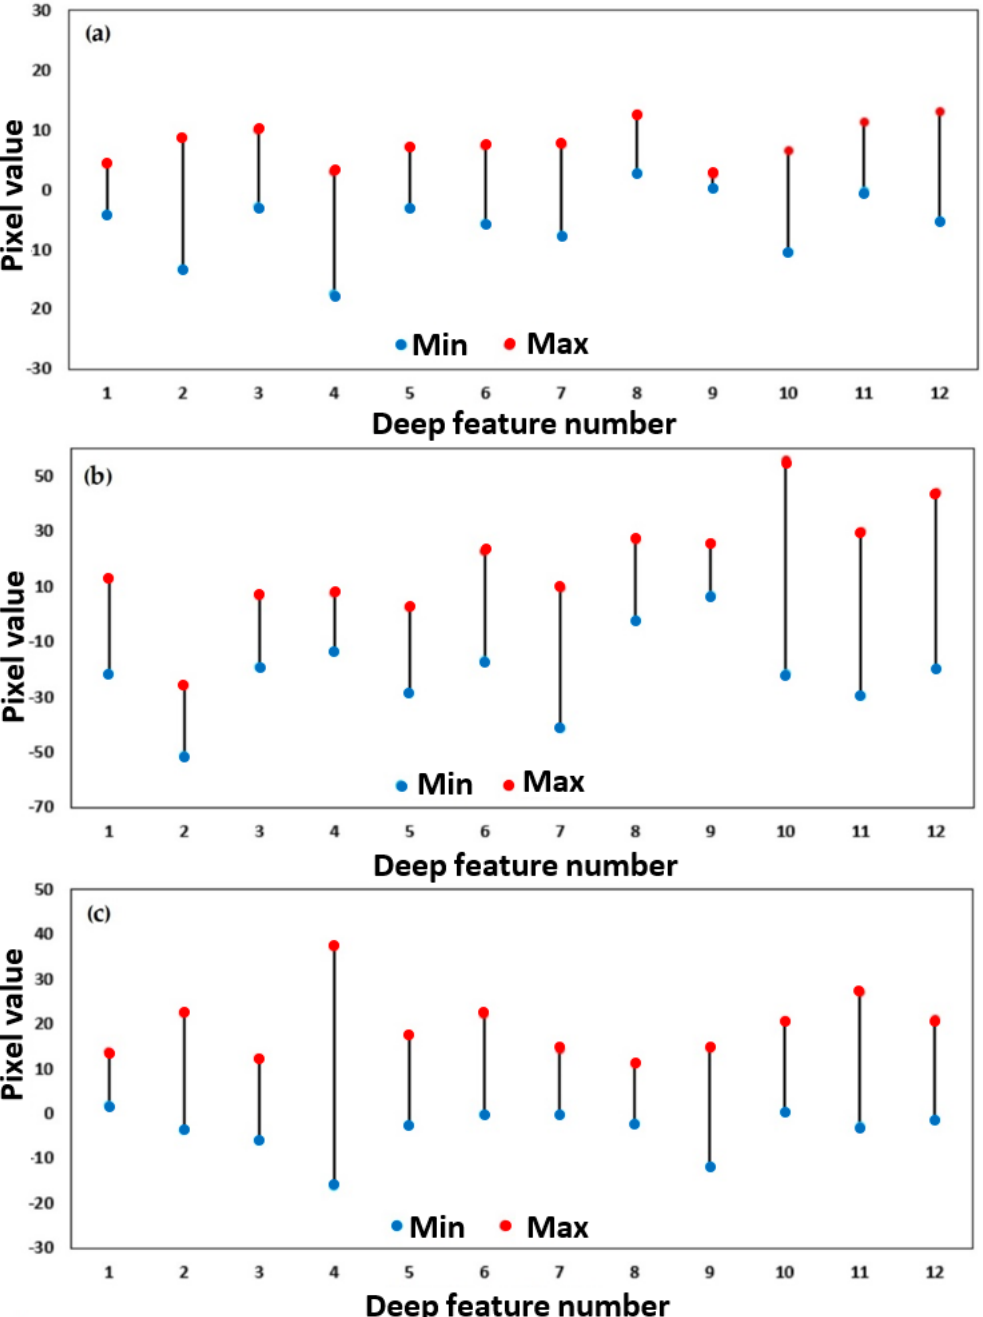
Figure 11. Pixel values range of reconstructed deep features of case studies in India ( a ), China ( b ), and Taiwan ( c ). Numbers 1–12 indicate the number of image features.